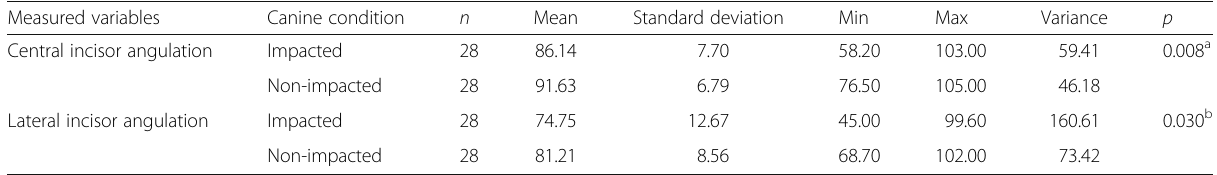
Table 5 Comparison of lateral angulation of long axis of incisors with respect to the nasal horizontal plane in bone and dentoalveolar dimensions of sample depending on the condition side of